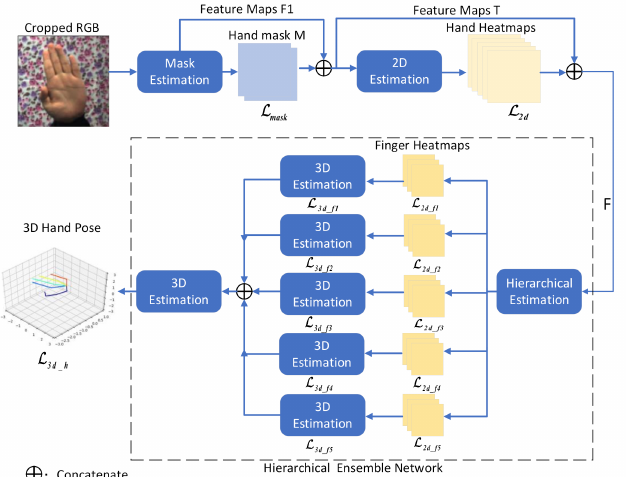
Figure 1. Schematic diagram of proposed 5LENet framework. Our 5LENet receives a cropped RGB image as the input to estimate hand mask. Then, the 2D hand heatmaps are estimated according to the features of RGB image and hand mask. Finally, 3D hand pose is estimated through the hierarchical ensemble network in the dotted